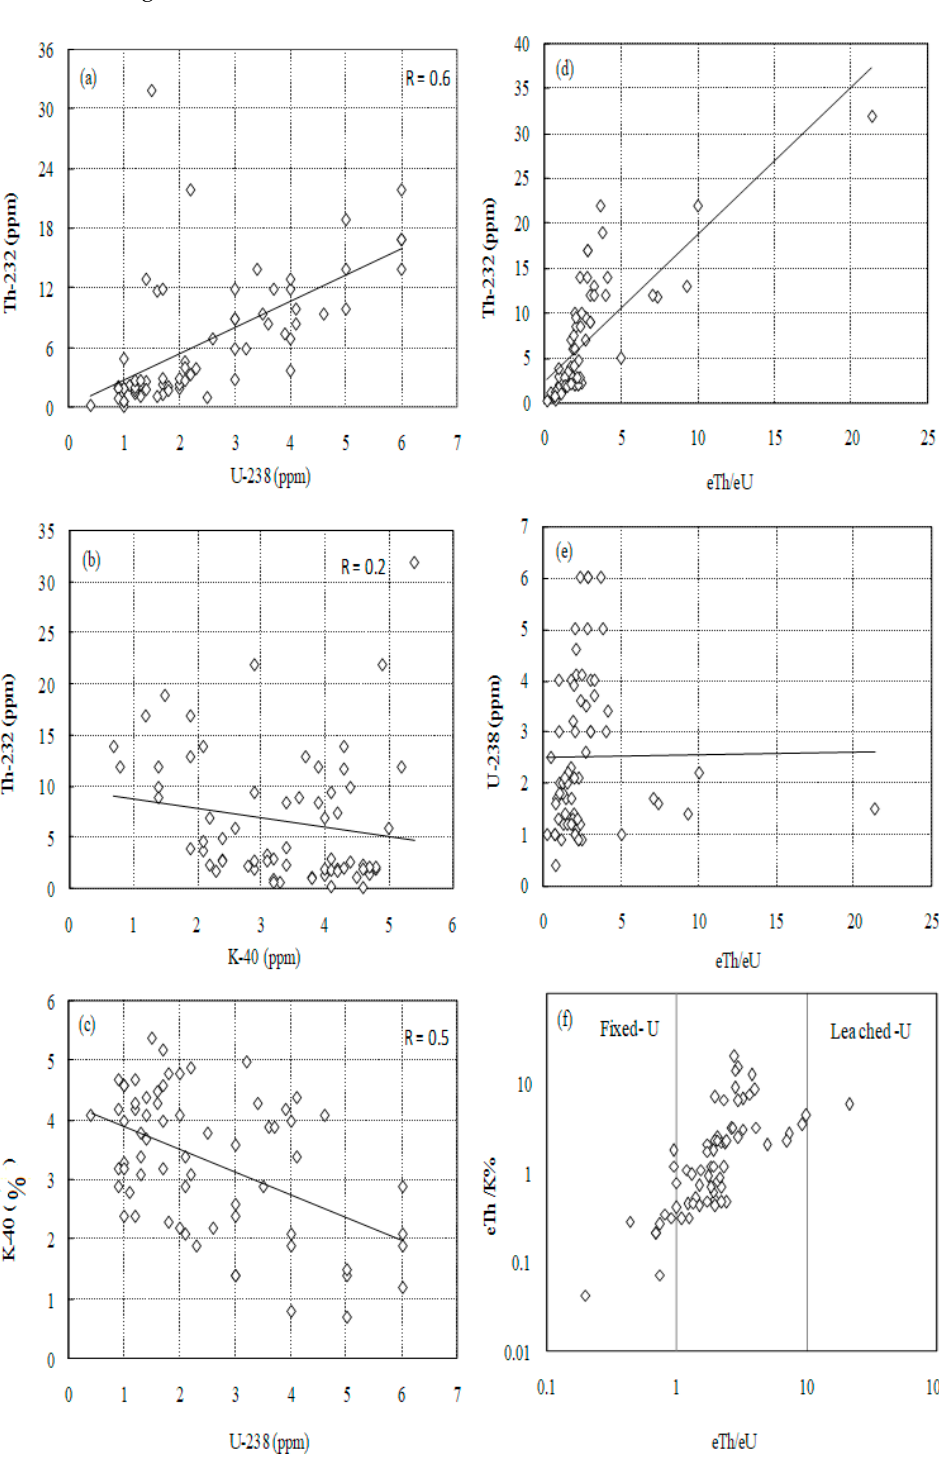
Figure 3. The radioactive correlations, ( a ) eTh vs. eU, ( b ) eTh vs. K% and ( c ) K vs. eU ( d ) eTh vs. eTh/eU, ( e ) eU vs. eTh/eU and ( f ) eTh/K% vs. eTh/eU for Hafafit pegmatite.